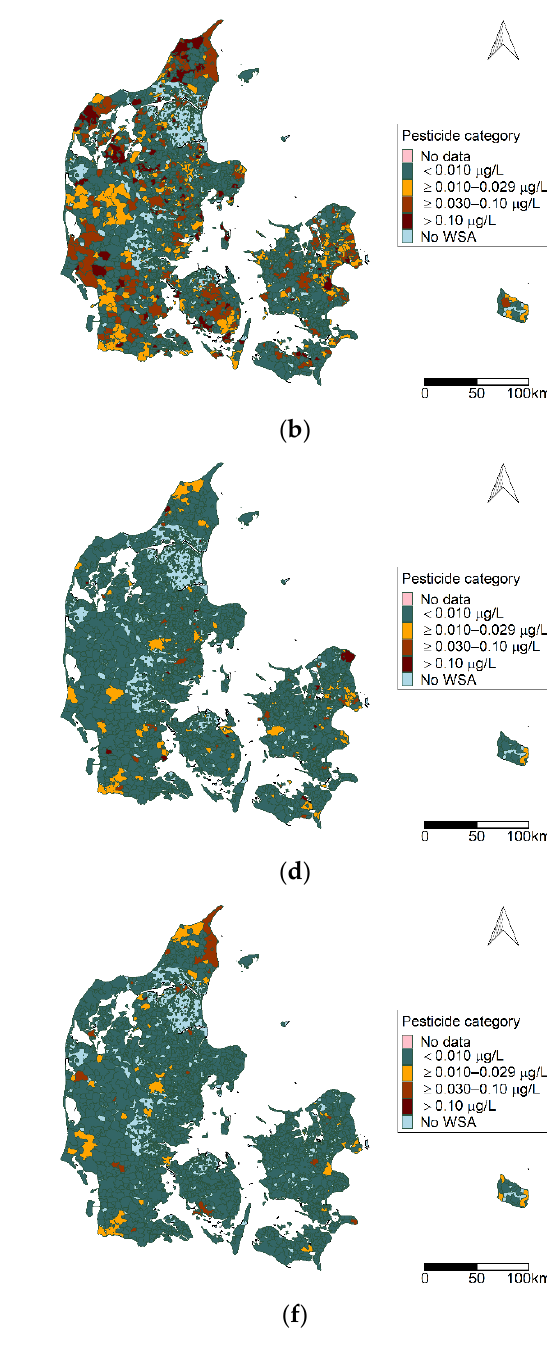
Figure 3. Geographic distribution of pesticide categories at the water supply area (WSA) level for selected pesticide groups for the period 2002 – 2018: ( a ) benzothiazinones; ( b ) benzonitriles; ( c ) organophosphates; ( d ) phenoxy herbicides; ( e ) triazines; ( f ) triazinones. Map contains data from the Danish Agency for Data Supply and Efficiency, municipality borders, 2019.